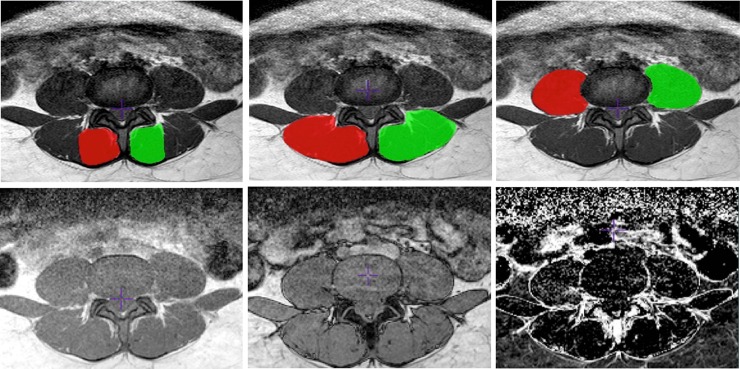
Superior line: Axial T1-weighted MRI at L4-L5 level with segmented lumbar muscles on Display® software.Right (green) and left (red) sides were indicated. Left: multifidus; center: erector spinae; right: psoas. Inferior line: Axial MRI sequences used to fat infiltration extraction. Left: In-Phase image; center: Out-Phase image; right: fat map.